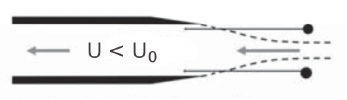
Figure 2. Sub-isokinetic sampling of ice particles by a nearly vir- tual inlet, where the velocity U inside of the inlet tube is much smaller than the flow speed U 0 . The dashed lines denote the region of the free stream from where the gas streamlines enter the inlet; the black dots illustrate large particles that do not follow the gas stream- lines, particle tracks are indicated by thin solid lines (adapted from Krämer et al.,